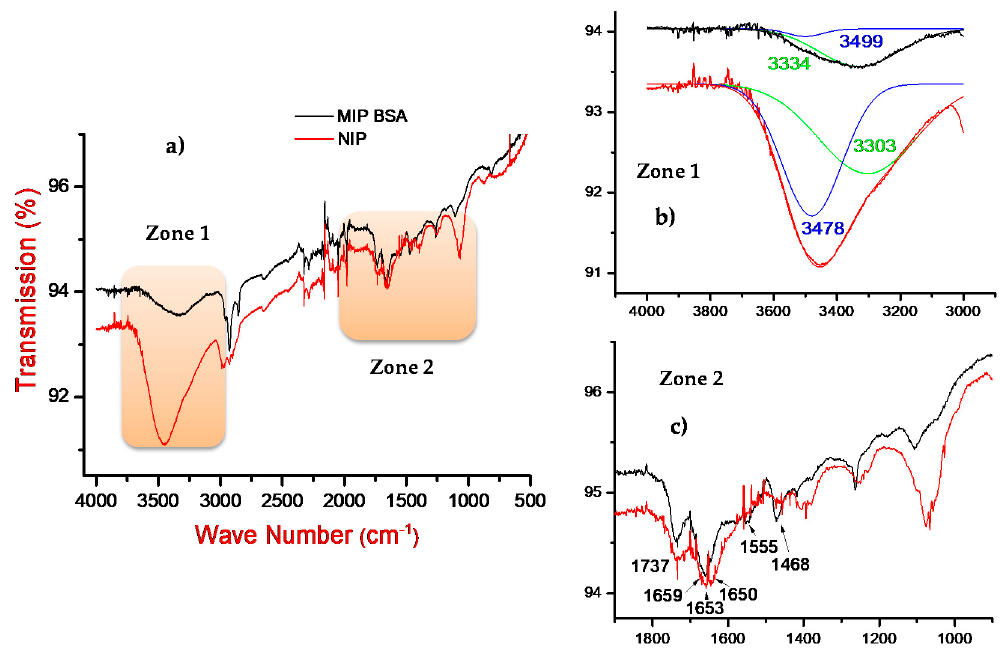
Figure 2. FTIR spectra of bovine serum albumin (BSA)/MIP and NIP at pH 7.4 ( a ) from 4000 to 500 cm − 1 . ( b ) A zoom on the zone 1 ranging from 4000 to 3000 cm − 1 and the corresponding Gaussian deconvolution. ( c ) A zoom on the zone 2 ranging from 1900 to 800 cm − 1 .